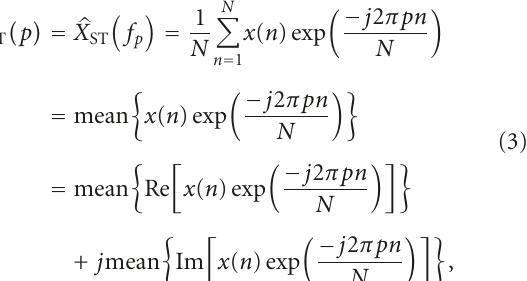
The optimal DFT method for Gaussian noise